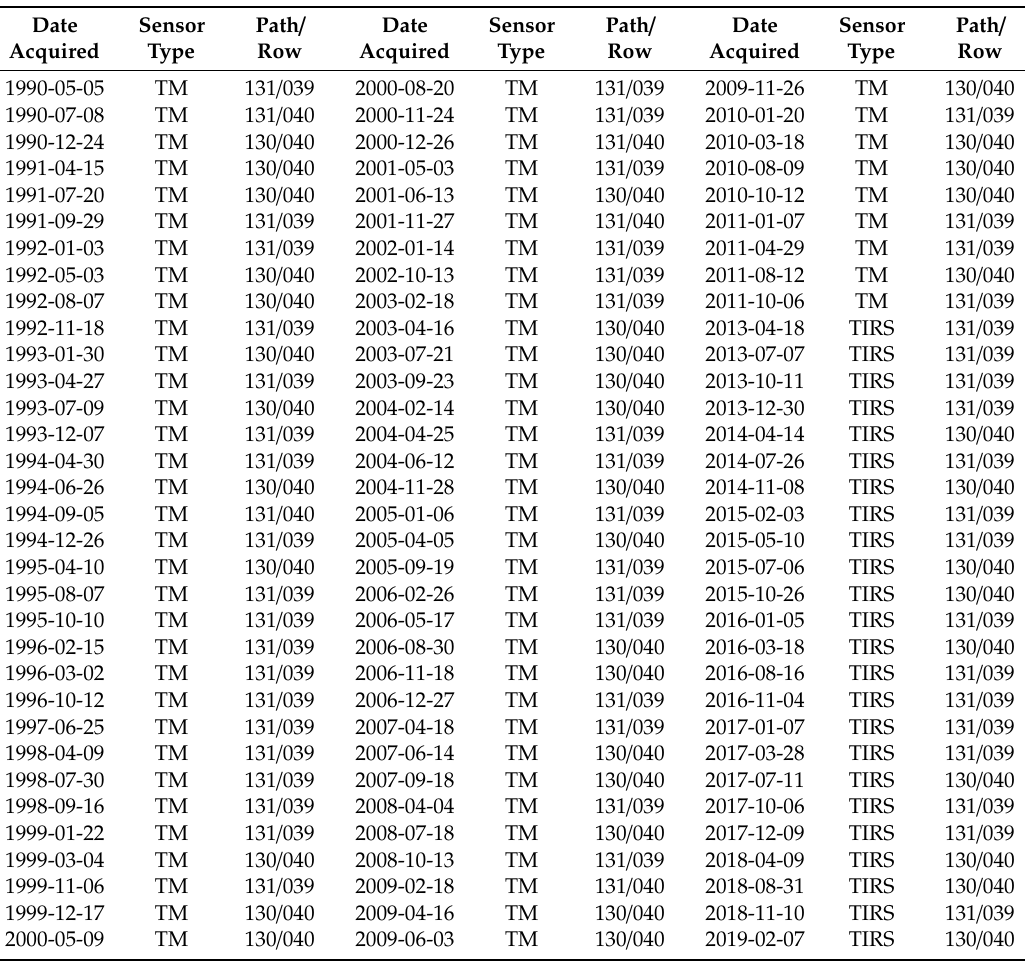
Table A1. Descriptions of the Landsat 5 TM data and Landsat 8 TIRS